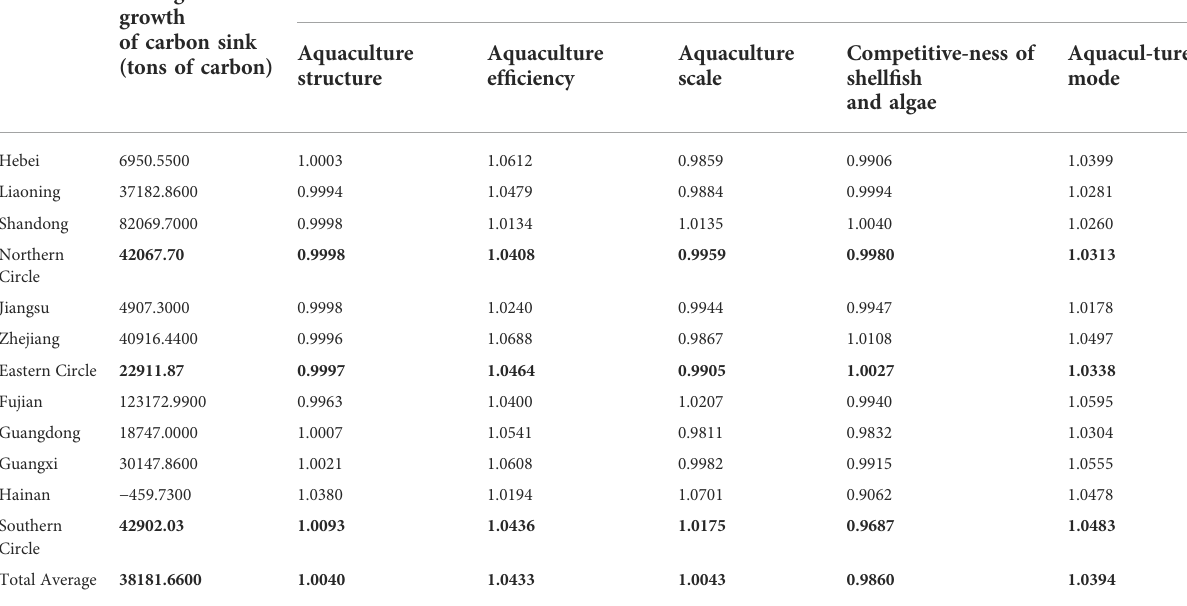
TABLE 6 Results of two-stage factor decomposition of the capacity of marine aquaculture to increase carbon sink from 2011 to 2019 (by region).